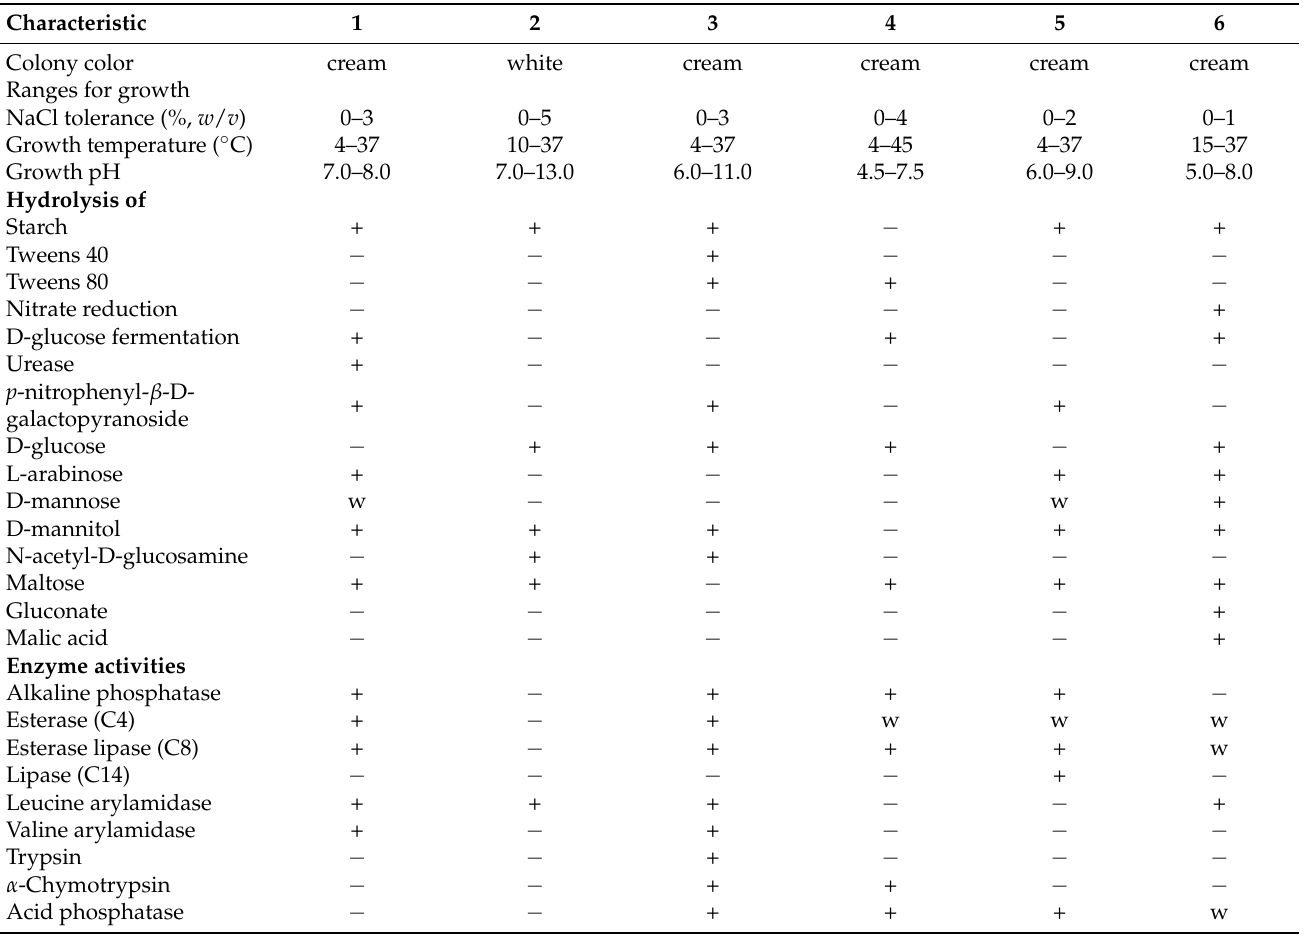
Table 1. Differential characteristics of novel strains and type strains of related species of the genus Paenibacillus